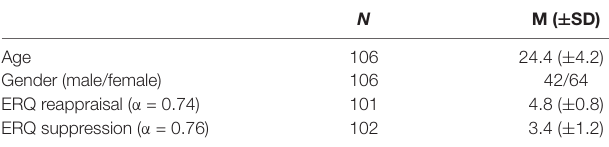
TABLE 1 | Sample characteristics and descriptive results of dispositional emotion